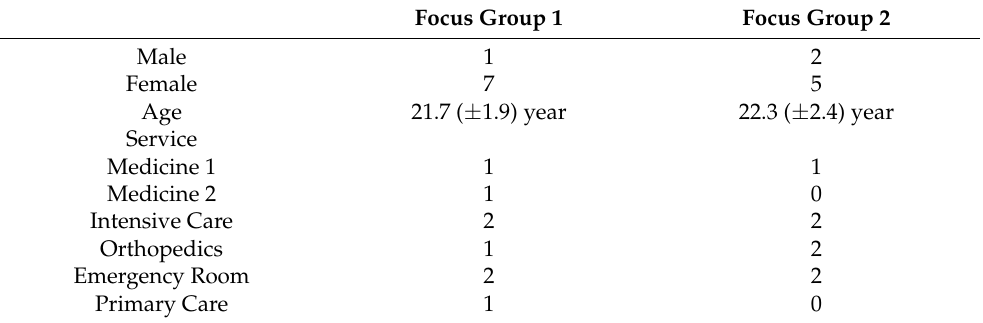
Table 1. Demographic data of the participants.